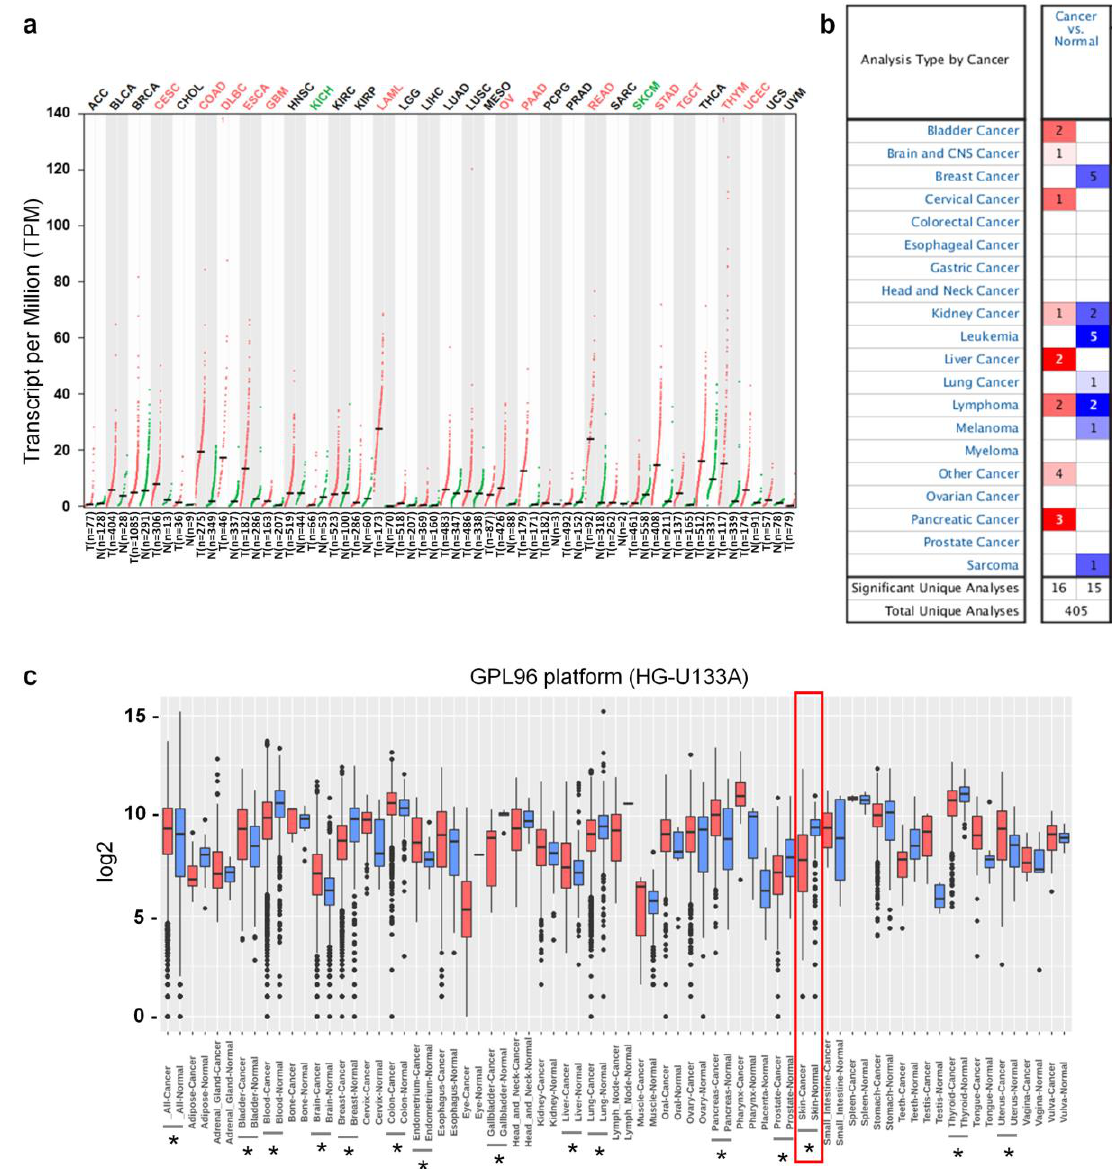
Figure 1. Transcription levels of Ly75 in di ff erent cancer type and their normal tissues. ( a ) Ly75 mRNA expression levels in various cancer type and their normal counterparts were retrieved from the Gene Expression Profiling Interactive Analysis (GEPIA) web tool (http: // gepia.cancer-pku.cn / ) as dot plots. Abbreviations of the names of cancer types and number of samples are listed in Supplementary Table S1. Cancer types in which Ly75 expression was significantly changed compared to normal counterparts were marked as red (increase) or green (decrease). ( b ) The number of datasets with Ly75 increased mRNA expression (left column, red) and decreased-expression (right column, blue) in cancers compared to normal tissues was retrieved using the Oncomine database (https: // www.oncomine.org / ) with the parameters: p -value of 10 − 4 , fold change of 2, and all gene ranking. ( c ) Boxplot for the Ly75 expression profile across cancer type generated with the Gene Expression Across Normal and Tumor Tissues (GENT2) database (http: // gent2.appex.kr / gent2 / ). The statistical significance of the di ff erence between each type of cancer and its corresponding normal tissue was estimated using a two-sample T-test, and p -values of less than 0.01 are marked by